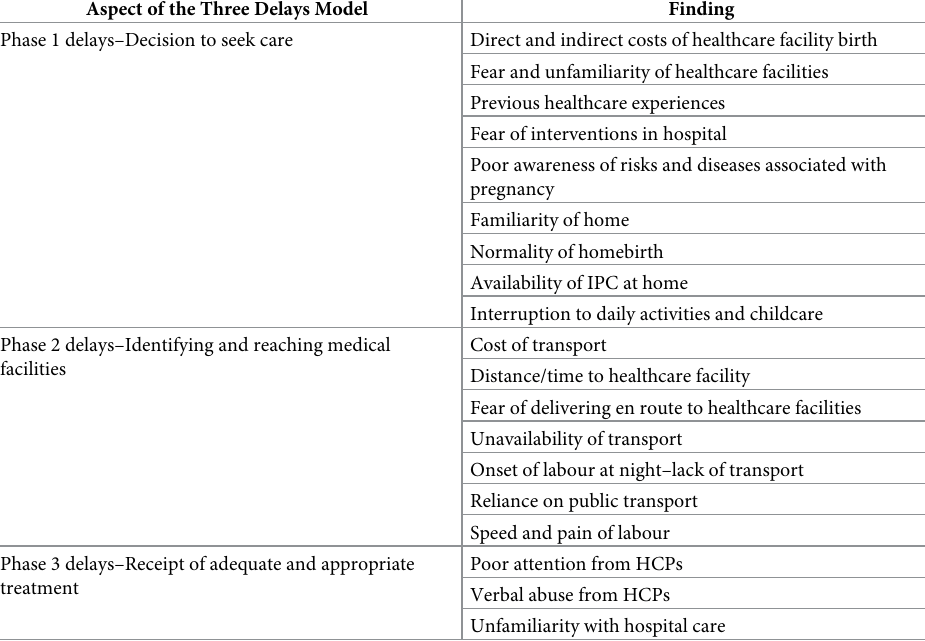
Table 4. Summary of findings summarised within the Three Delays